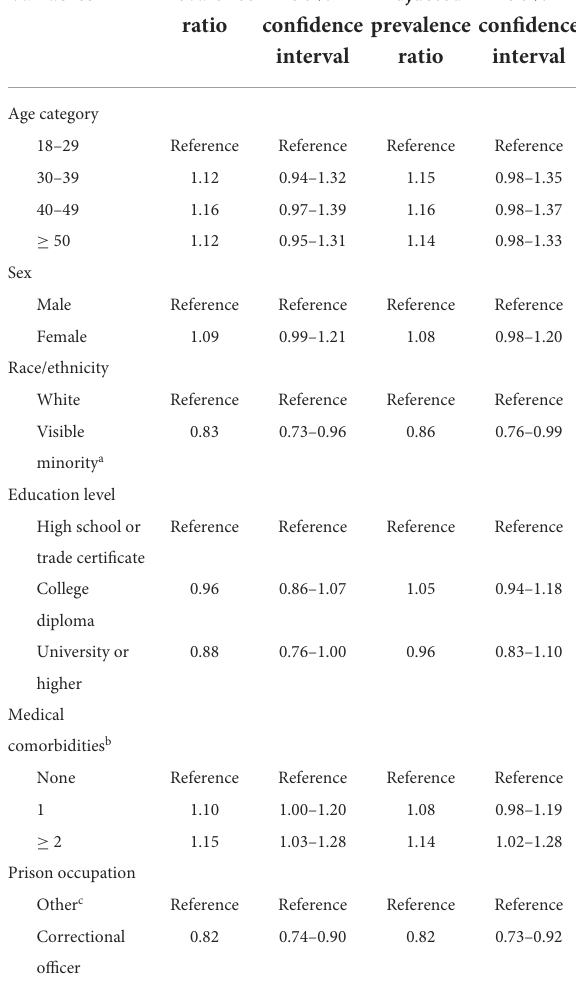
TABLE 3 Univariate and multivariable analyses of predictors of COVID-19 vaccination status among correctional workers in three provincial prisons in Quebec, Canada